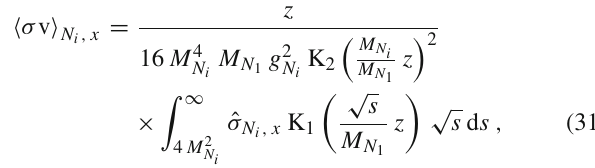
The thermally average annihilation cross sections equations (Eqs. (25) and (26)) for the processes shown in Fig. 4, can be defined in a generic